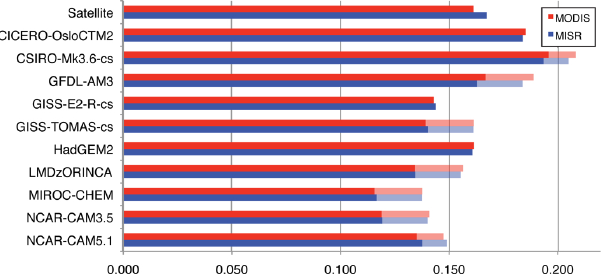
Fig. 2. Global mean area-weighted annual average AOD (550nm) seen by the MODIS and MISR instruments and in the indicated models sampling when and where MODIS and MISR provide ob- servations. Solid bars show model total AOD values while light shaded areas show the multi-model mean contribution from nitrate or nitrate and SOA in those models that do not include those species.